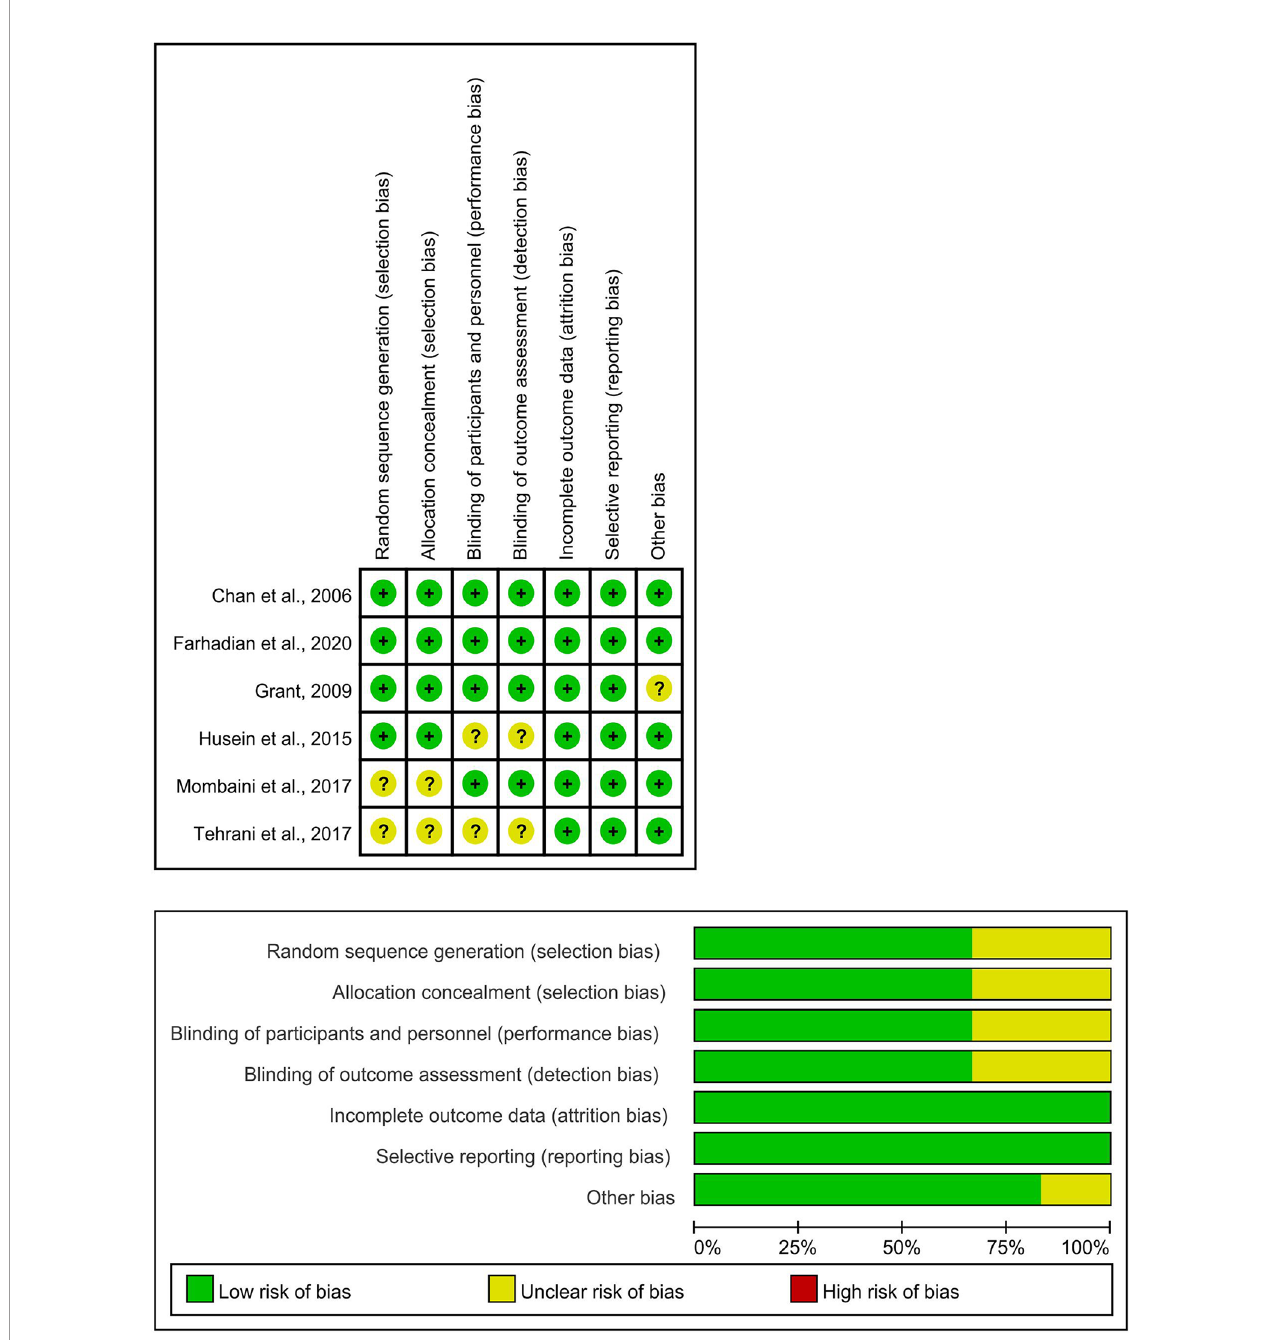
FIGURE 2 | Risk of